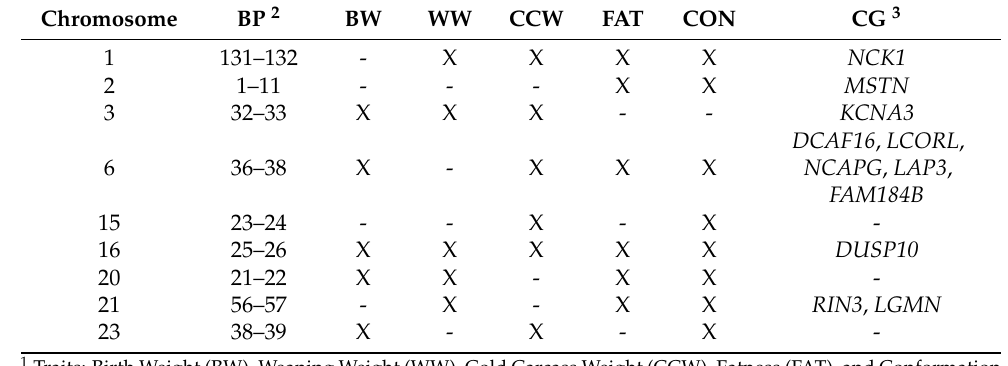
Table 3. Regions of the genome that explained a percentage of variance above 0.5% and the pair bases distance, the traits 1 in which these regions appear, and the candidate genes with a pleiotropic effect. Chromosome BP